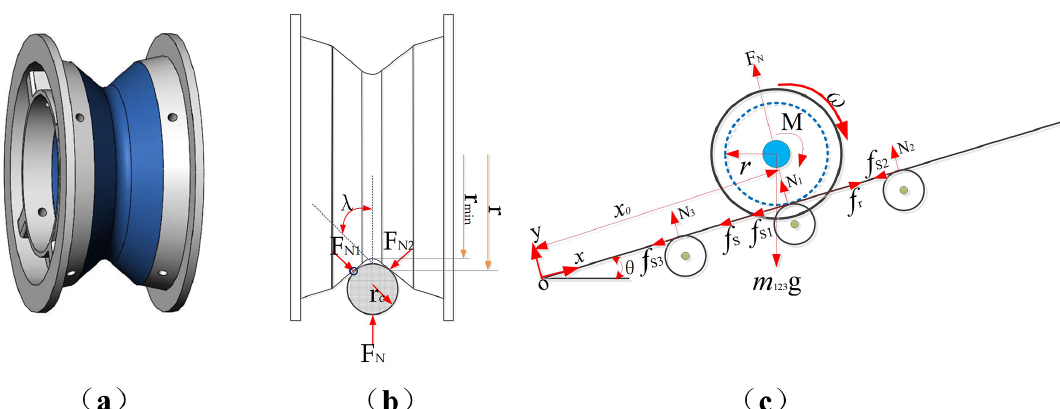
Figure 9. Dynamics model of the walking mechanism. (a) The structural design of the FPLIR with the walking wheel. (b) Schematic diagram of the FPLIR walking along the power line. (c) Schematic diagram of the FPLIR moving the whole robot along the power line for the dynamic